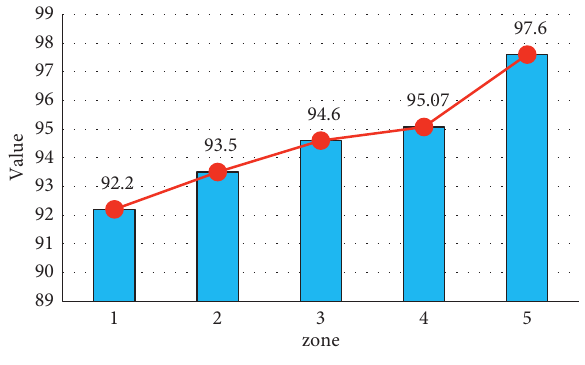
Figure 3: Predicted